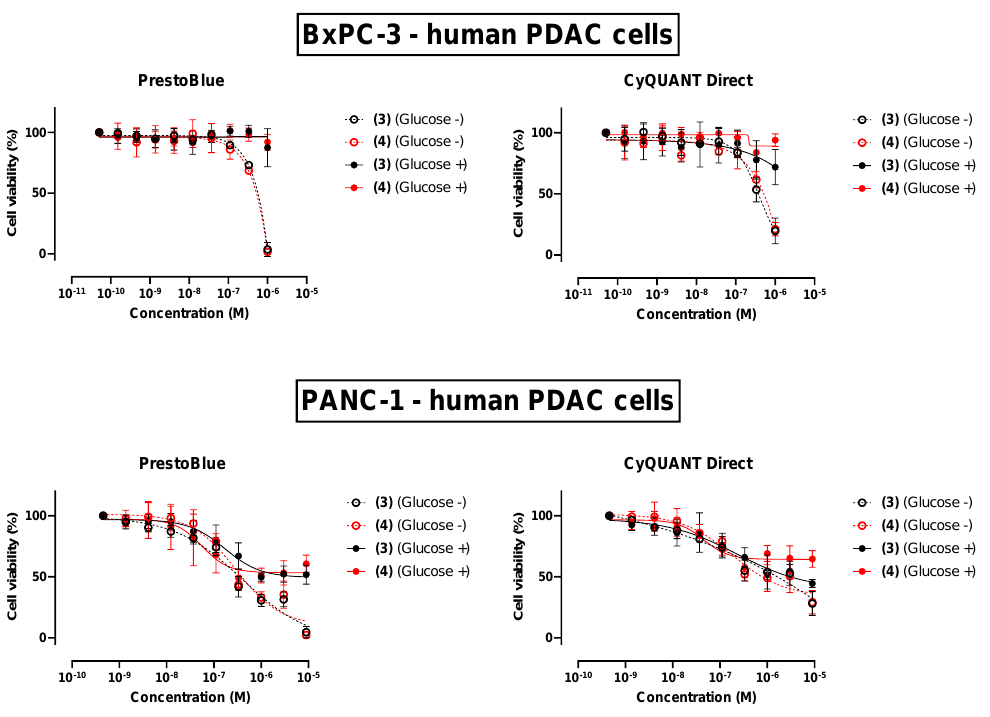
Figure 5. Comparative percent viability of BxPC-3 and PANC-1 human PDAC cells cultured under ‘low glucose’ (Glucose − ) and ‘normal glucose’ (Glucose +) conditions following a 24 h exposure to trichoderin A ( 3 ) and its simplified analogue ( 4 ), as judged by the PrestoBlue™ and CyQUANT™ Direct assays. Table 1. Drug response metrics table (IC 50 , AUC, and E max ) of trichoderin A ( 3 ) and its analogues ( 4 ) , ( 12 ) – ( 19 ) against BxPC-3 and PANC- 1 cells cultured under ‘low glucose’ condition, as judged by the PrestoBlue ™ and CyQUANT ™ Direct assays. All values are shown in 1 decimal place (d.p.). The most active entry in the series is highlighted in yellow.